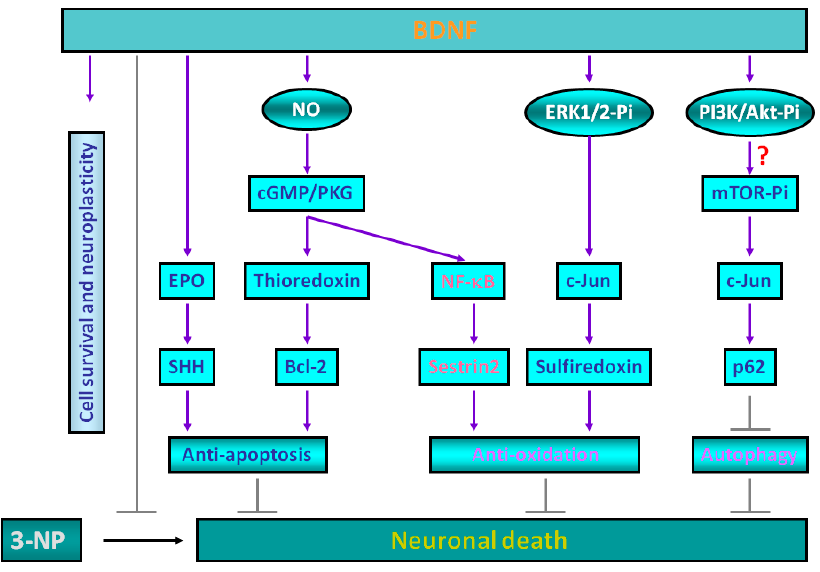
Figure 1. Multiple neuroprotective mechanisms including anti-apoptosis, anti-oxidation, and autophagy suppression are inducible by brain-derived neurotrophic factor (BDNF). The neuroprotective actions of BDNF against mitochondrial dysfunction associated with exposure to 3-nitropropionic acid (3-NP) in cortical neurons involve a number of different molecular mediators. First, BDNF may induce sonic hedgehog (SHH) via erythropoietin (EPO) that together contribute to its anti-apoptotic actions [29,30]. Second, BDNF preconditioning also triggers the induction of nitric oxide (NO) with the enhanced production of cGMP as well as increased expression of PKG-1, together leading to the expression of anti-oxidative thioredoxin and anti-apoptotic Bcl-2 proteins [19,31]. Third, the BDNF-induced NO/cGMP/PKG pathway also contributes to the activation of the redox-sensitive transcription factor NF- κ B; indeed, upon BDNF exposure, PKG-1 forms a protein complex with the NF- κ B subunits p65 and p50 and translocates into the neuronal nucleus to drive the expression of sestrin2, which attenuates cellular ROS contents produced by 3-NP [20]. Fourth, BDNF stimulates the phosphorylation of extracellular signal-regulated kinase-1/2 (ERK1/2) with subsequent induction of another transcription factor c-Jun, thereby leading to the expression of an ATP-dependent antioxidant enzyme sulfiredoxin [32]. Finally, BDNF also activates mTOR and induces c-Jun to drive the expression of p62 that suppresses the 3-NP-induced activation of autophagy and neuronal death [21].